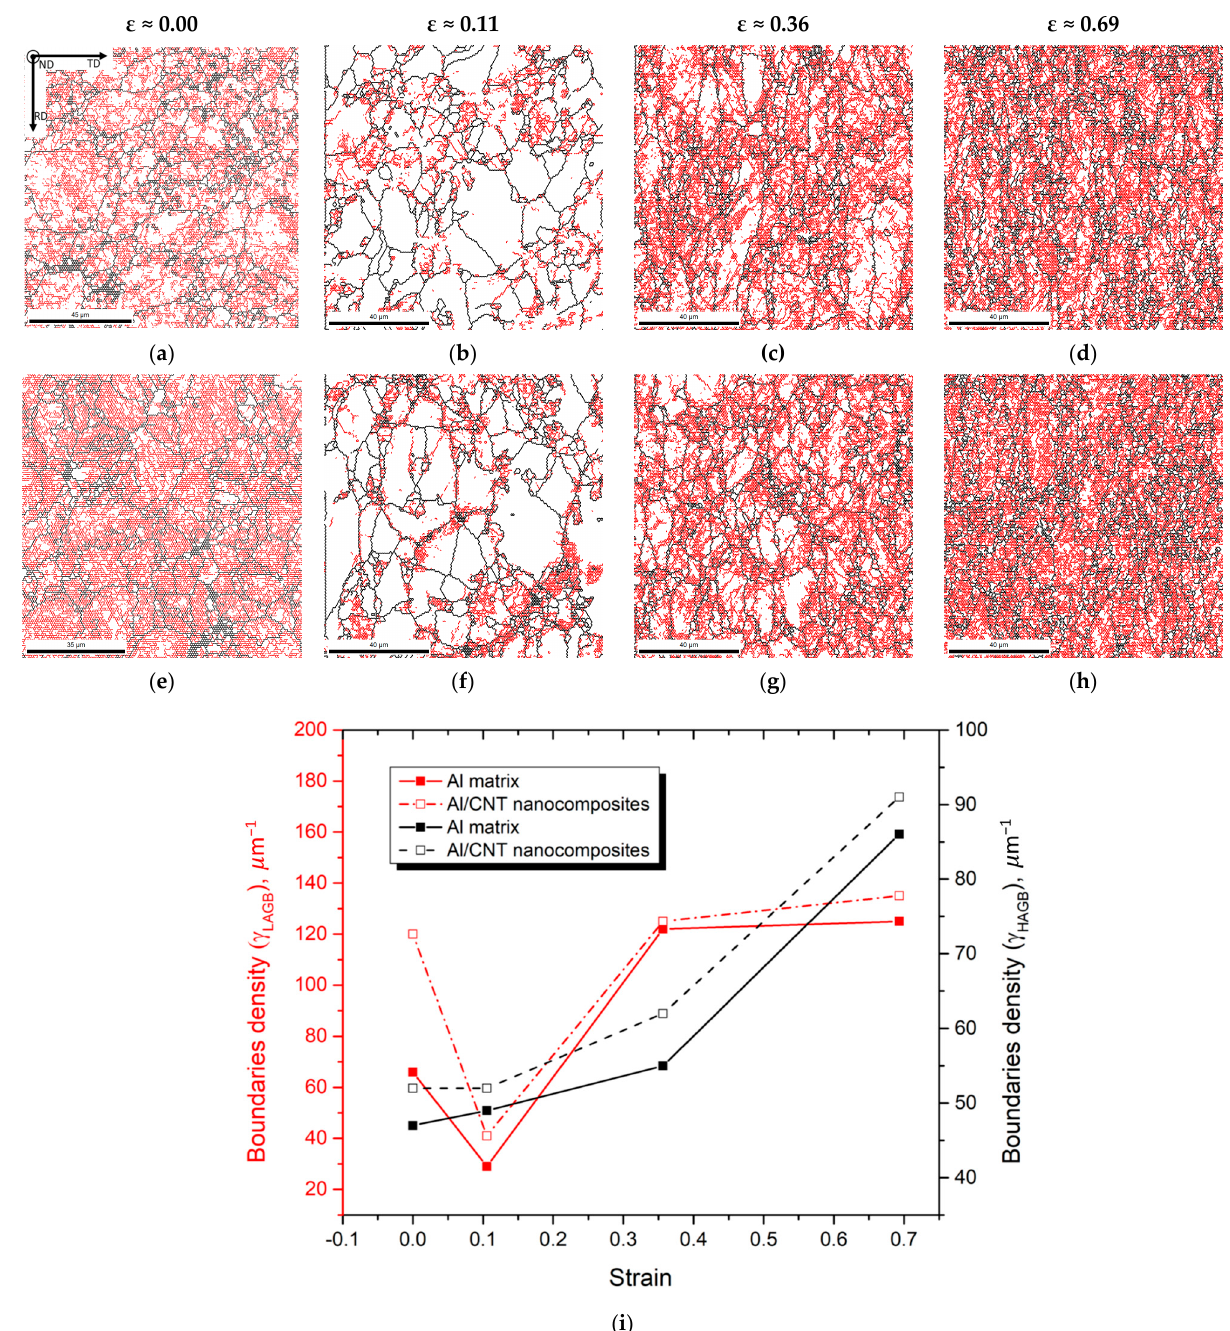
Figure 6. Electron backscatter diffraction (EBSD) maps showing the different boundary types (black—HAGB and red—LAGB). ( a – d ) Al and ( e – h ) Al/CNT samples, cold rolled to strains of 0.00, 0.11, 0.36, and 0.69, and ( i ) evolution of LAGB and HAGB for the Al and Al/CNTs samples, as-sintered and cold rolled.